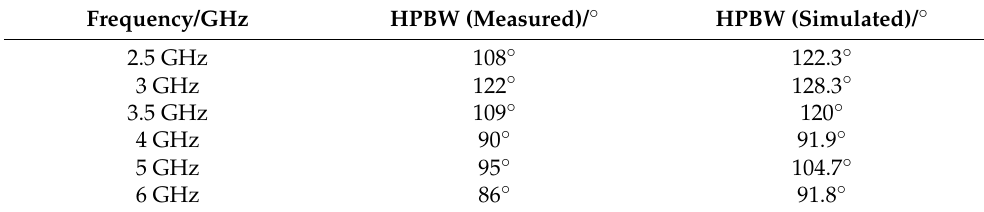
Figure 3. Simulated E-plane radiation patterns of the transmitting antenna with structure at ( a ) 2.5 GHz; ( b ) 3 GHz; ( c ) 3.5 GHz; and ( d ) 4 GHz; ( e ) 5 GHz; ( f ) 6 GHz. Table 2. The beam width of the transmitting antenna at different frequency.